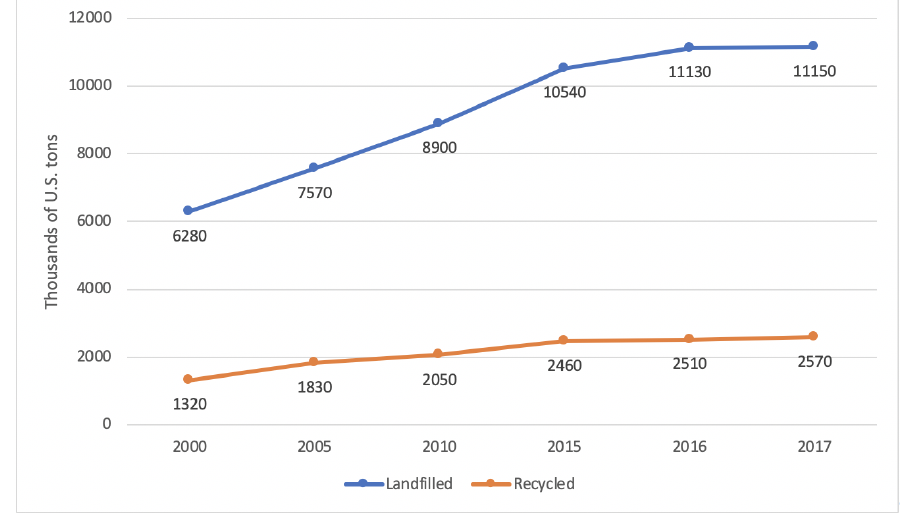
Figure 1. Landfilled tons of textiles produced and recycled in the 21st century